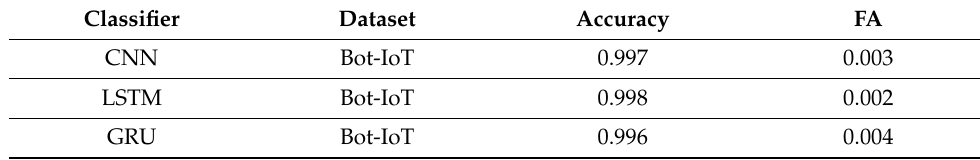
Table 4. Result experiment for accuracy and false